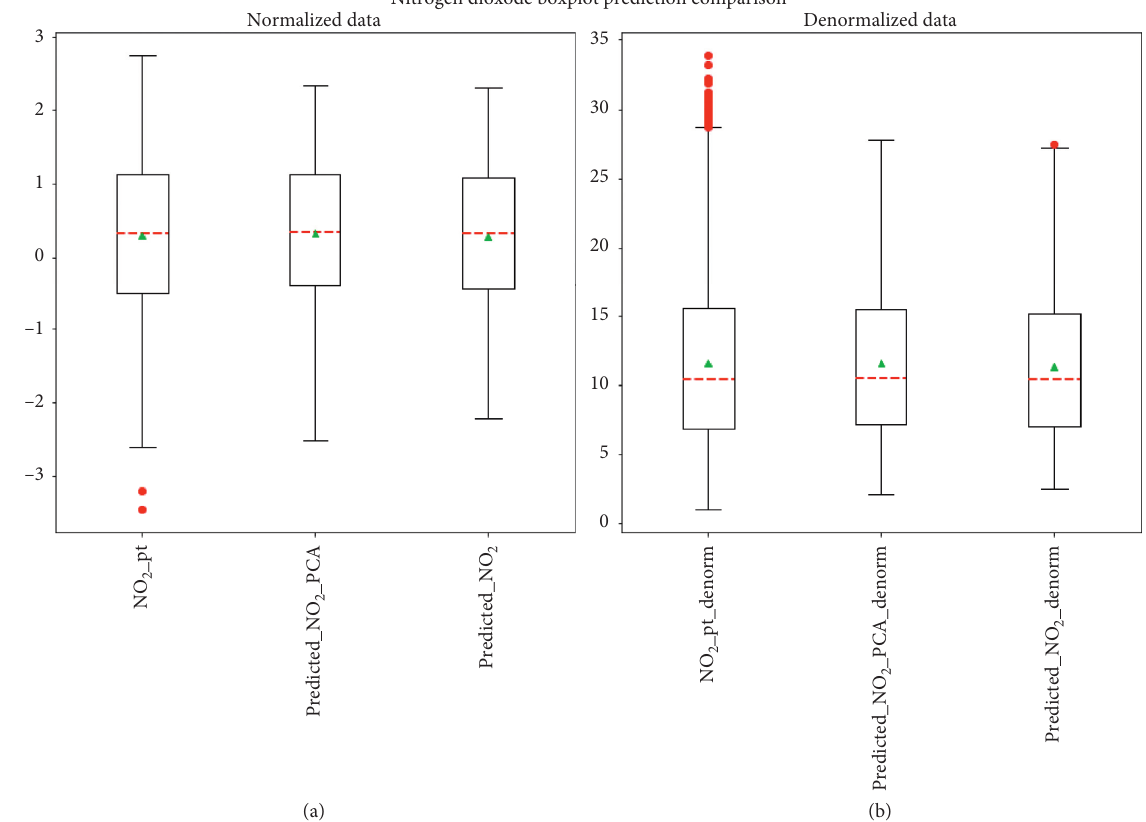
Figure 12: Boxplot representation of observed and forecasted nitrogen dioxide values (PCA SVR-RBF and SVR-RBF values, before and after Yeo-Johnson power transformation). Table 8: Error metrics from NO 2 forecasting models in the training and validation sets. Error